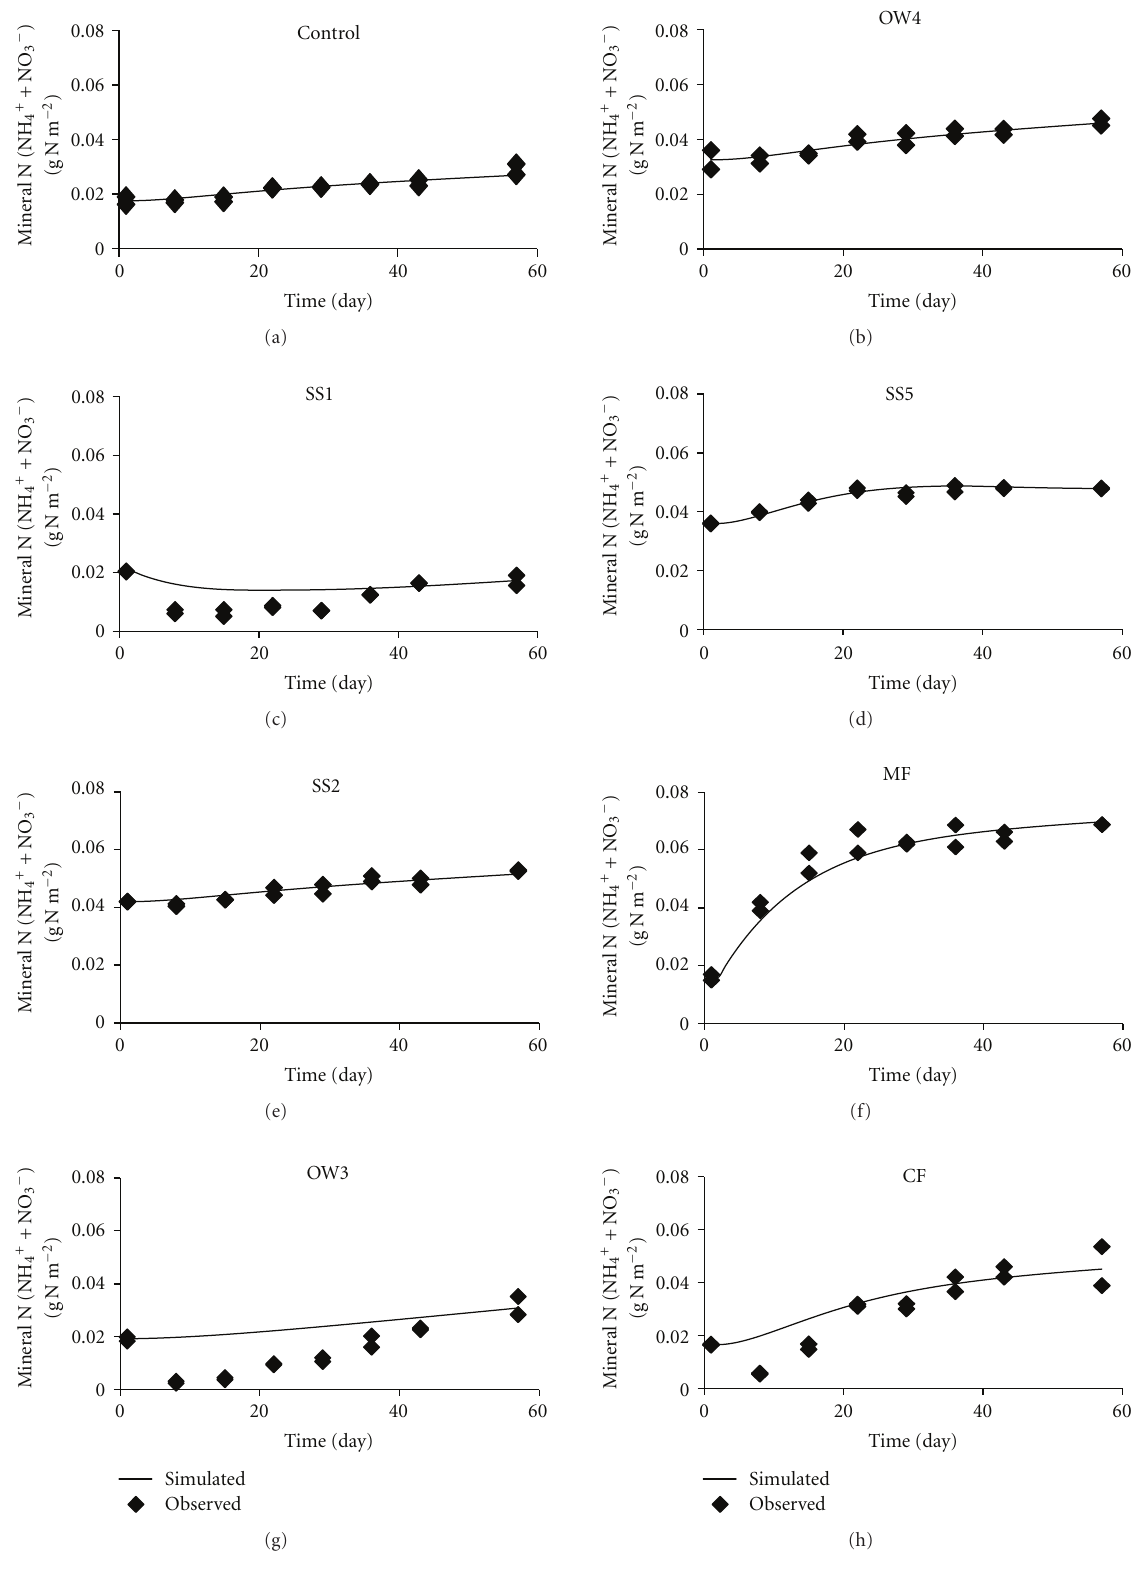
Figure 2: Simulated and observed mineral N [gNm − 2 ] from the laboratory incubation experiment. SS1 = raw, primary (before stabilising or sanitary treatments) sewage sludge, SS2 = stabilised, sanitary treated and digested (anaerobic) sewage sludge, OW3 = primary source sorted (not composted) organic waste, OW4 = easily composted (aerobic) organic waste, SS5 = rotator treated (composted, and mixed with bark and chips) sewage sludge compost, MF = meat flour and CF = cow